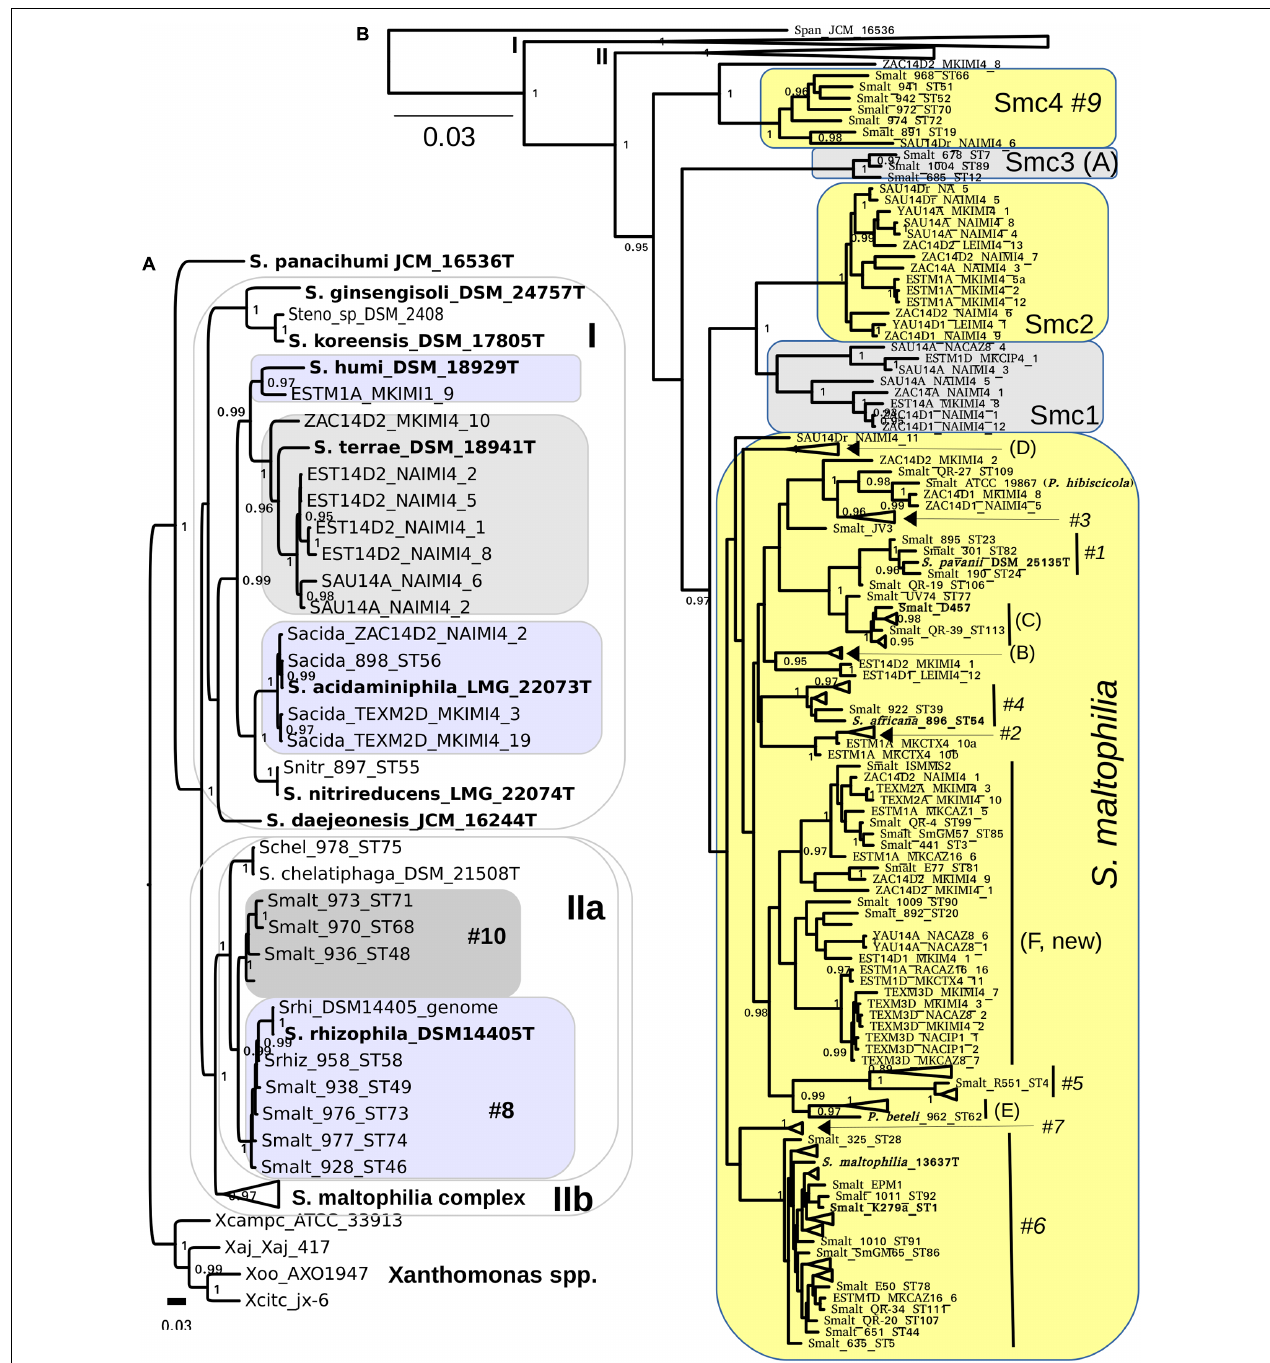
FIGURE 1 | Maximum likelihood multilocus phylogeny of the genus Stenotrophomonas and species delimitation hypotheses. The tree shown corresponds to the best one found out of 1001 searches under the GTR + G model and BEST moves, using the concatenated alignment (7-loci) for 194 non-redundant STs, containing all validly described species of the genus except for S. tumulicola , additional key reference strains and 63 haplotypes from the 108 Mexican environmental isolates analyzed in this study. (A) The S. maltophilia complex (Smc) clade is collapsed in this tree. (B) The Smc clade is displayed, collapsing the clades visible in (B) . Clades are labeled using the A-E codes of Kaiser et al. (2009) and #1–#10 of Hauben et al. (1999) for easy cross-reference. The shaded areas indicate species assignation hypotheses specifically evaluated in this study by the multispecies coalescent using Bayes factors and by population genetics analyses ( Tables 2 , 3 ). The combined evidence of both approaches reveals that the Smc complex should be split into S. maltophilia and four new genospecies: Smc1, Smc2, Smc3, and Smc4 (B) . We also show (A) that genotype #10 represents a non-described species that should not be merged with S. rhizophila clade #8 ( Table 2 ). Type and other key reference strains are highlighted in bold-face. The bar indicates the number of expected substitutions per site under the GTR + G model.